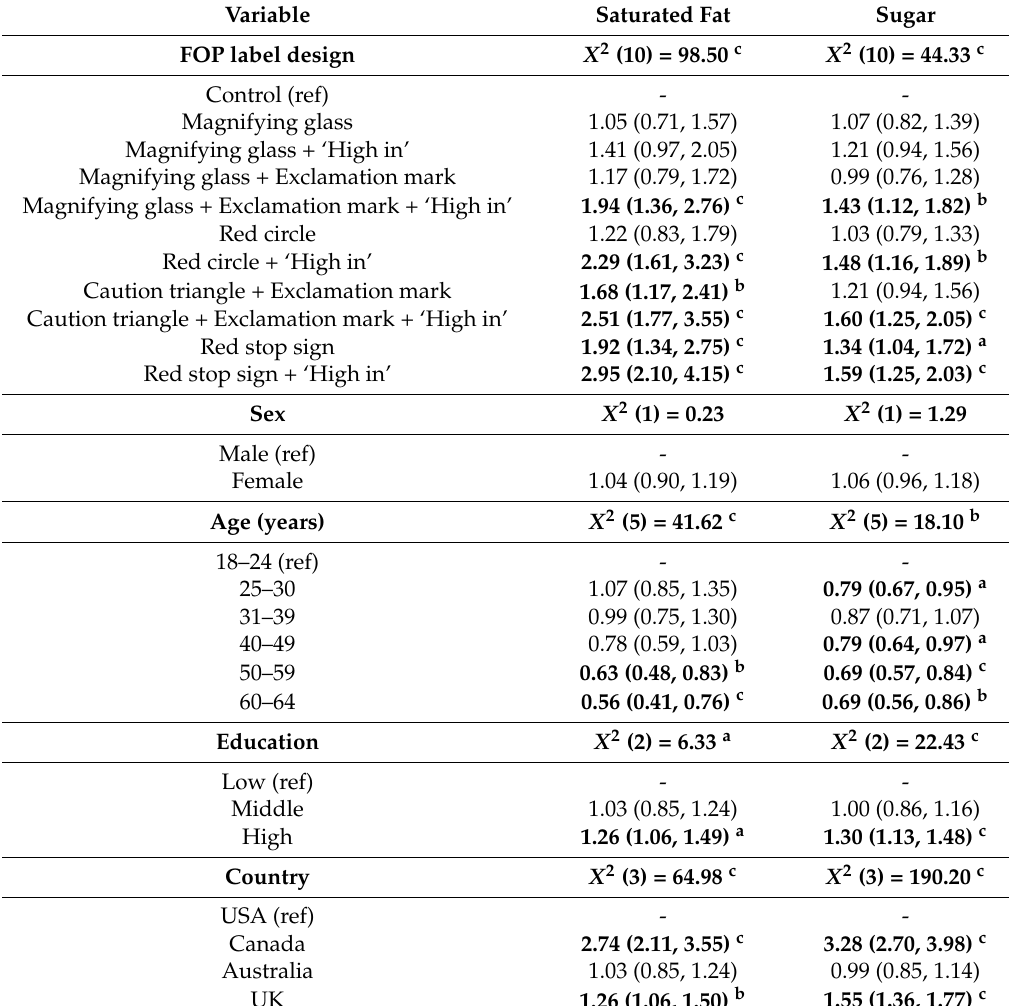
Table 3. Odds (OR, 95%CI) of a correct response * for each nutrient of concern ( n = 11,617) **.